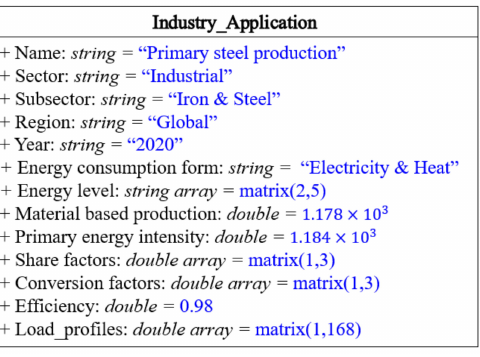
Figure 7. An example of an Industry application object, showing the assigned attributes. Table 13. Dispatch module–inputs, intermediate outputs and